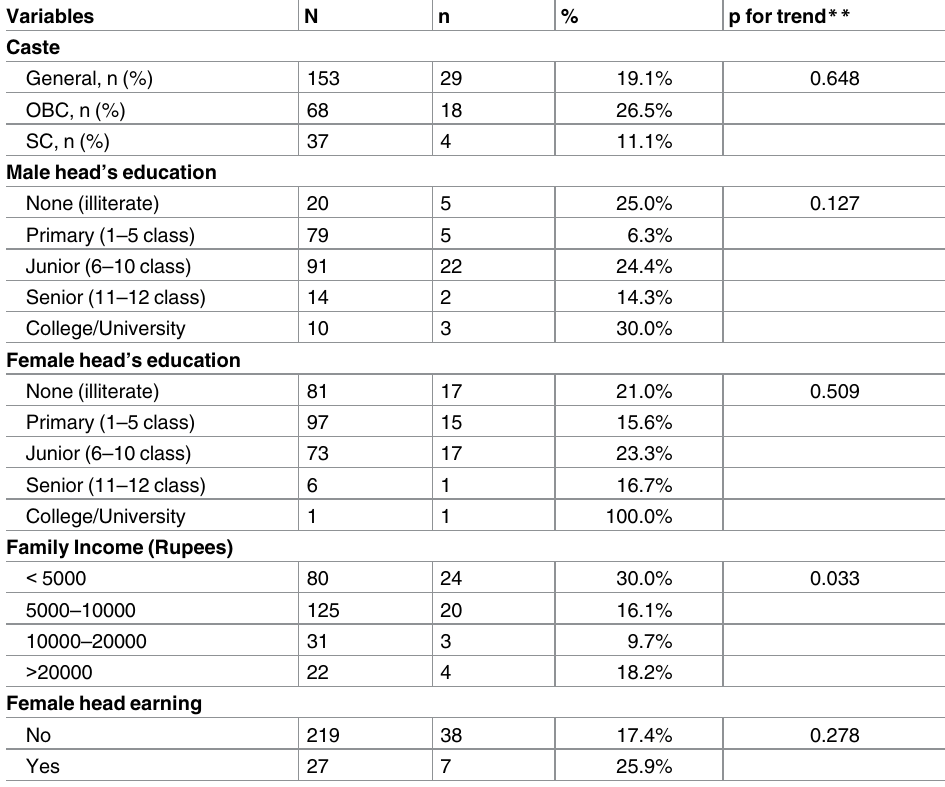
Table 5. Association between socio-economic status and women’s decision making to build latrine * . Variables